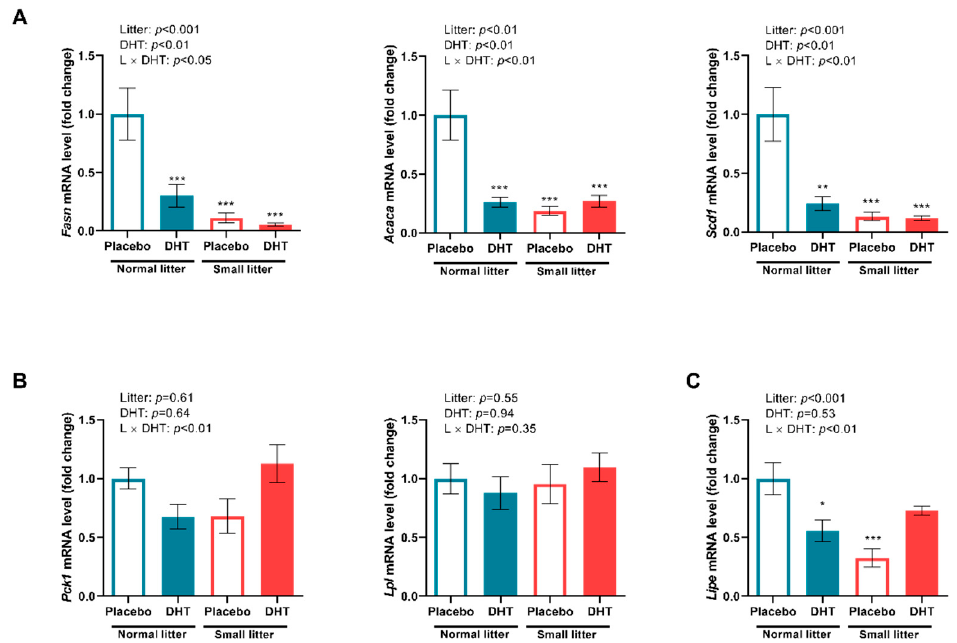
Figure 4. Relative expression of lipogenesis and lipolysis markers in the VAT of placebo and DHT treated rats from small and normal litters. ( A ) Relative expression of Fasn , Acaca, and Scd1 gene. ( B ) Relative expression of Pck1 and Lpl gene. ( C ) Relative expression of Lipe gene. The gene expression was normalized to Hprt , Tbp or B2m gene expression and the data are presented as mean ± SEM ( n = 6 animals per group). To determine the effects of litter size reduction and DHT treatment, as well as their interaction, two-way ANOVA, followed by Tukey post hoc test was performed, and the difference was considered significant at p < 0.05. Symbols denote significant statistical differences between NL-Placebo and NL-DHT, SL-Placebo or SL-DHT groups (* p < 0.05, ** p < 0.01, *** p < 0.001).